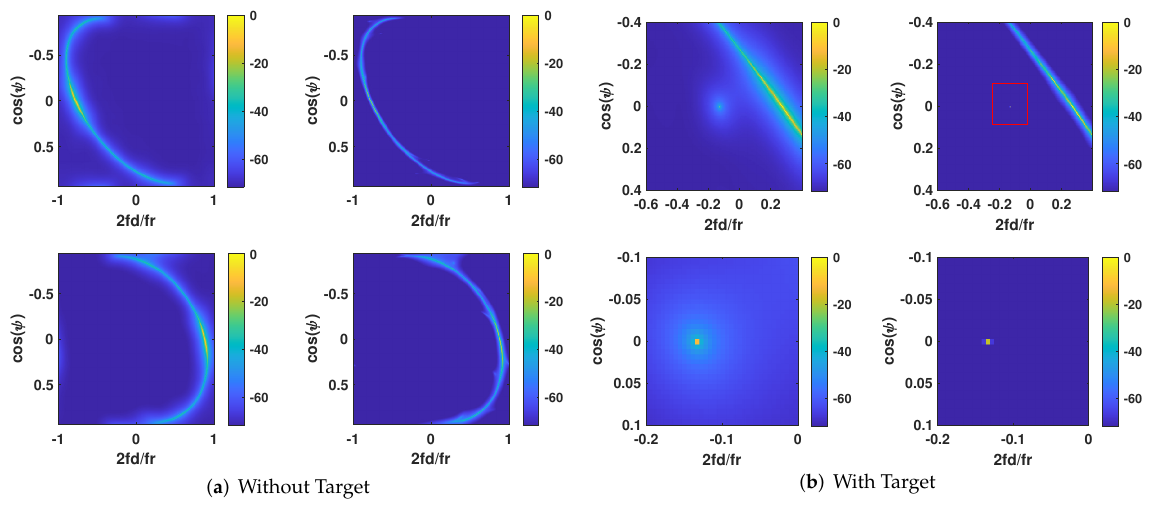
Figure 2. ( a ) Space-time distributions of non-uniform clutter caused by non-side-looking array with data of original STAP and proposed method. ( b ) Space-time distributions of target and non- uniform clutter.